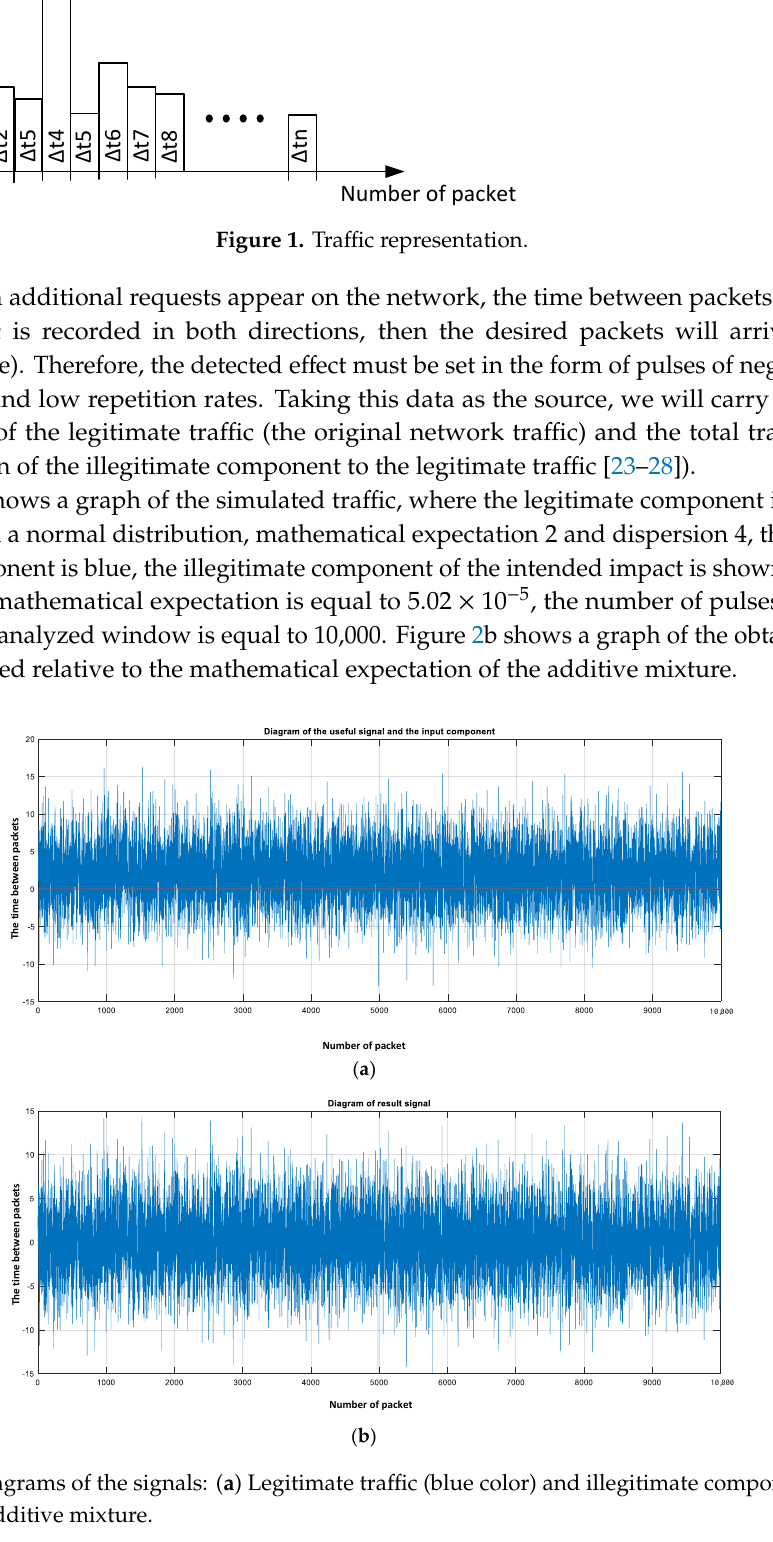
No Figure 3. Algorithm for specifying the legitimate and illegitimate traffic.